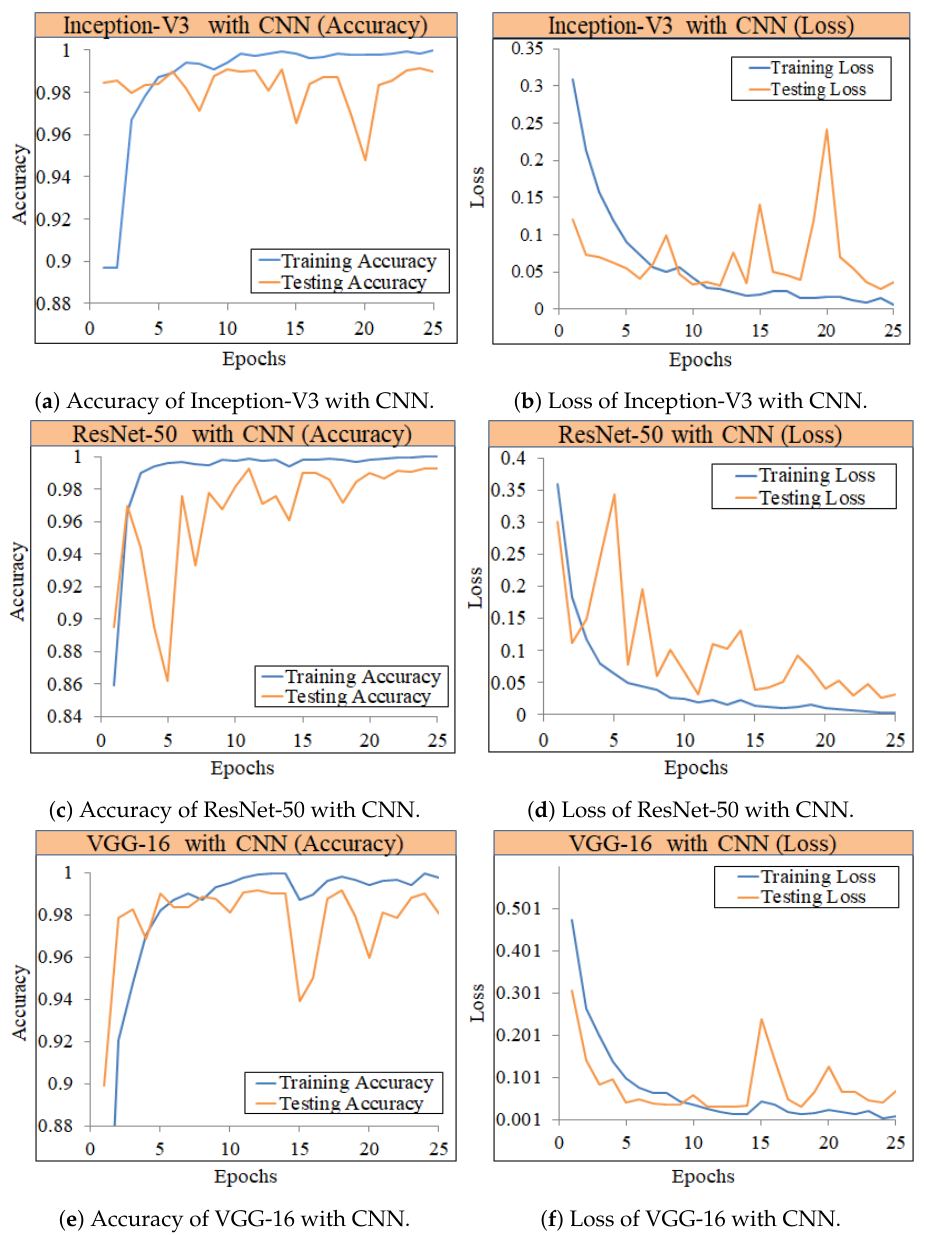
Figure 6. Training and testing accuracy of ensemble models. ( a ): Training and testing accuracy for Inception-V2 with CNN, ( b ): Training and testing loss for Inception-V2 with CNN, ( c ): Training and testing accuracy for ResNet-50 with CNN, ( d ): Training and testing loss for ResNet-50 with CNN, ( e ): Training and testing accuracy for VVG-16 with CNN and ( f ): Training and testing loss for VVG-16 with